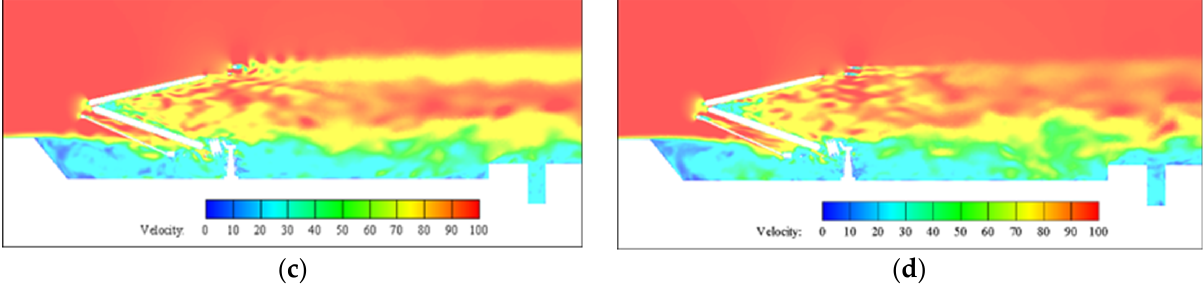
Figure 4. The velocity amplitude distribution on the longitudinal symmetry surface. ( a ) Original model. ( b ) Opened model. ( c ) Slotted model. ( d ) Airfoil model.